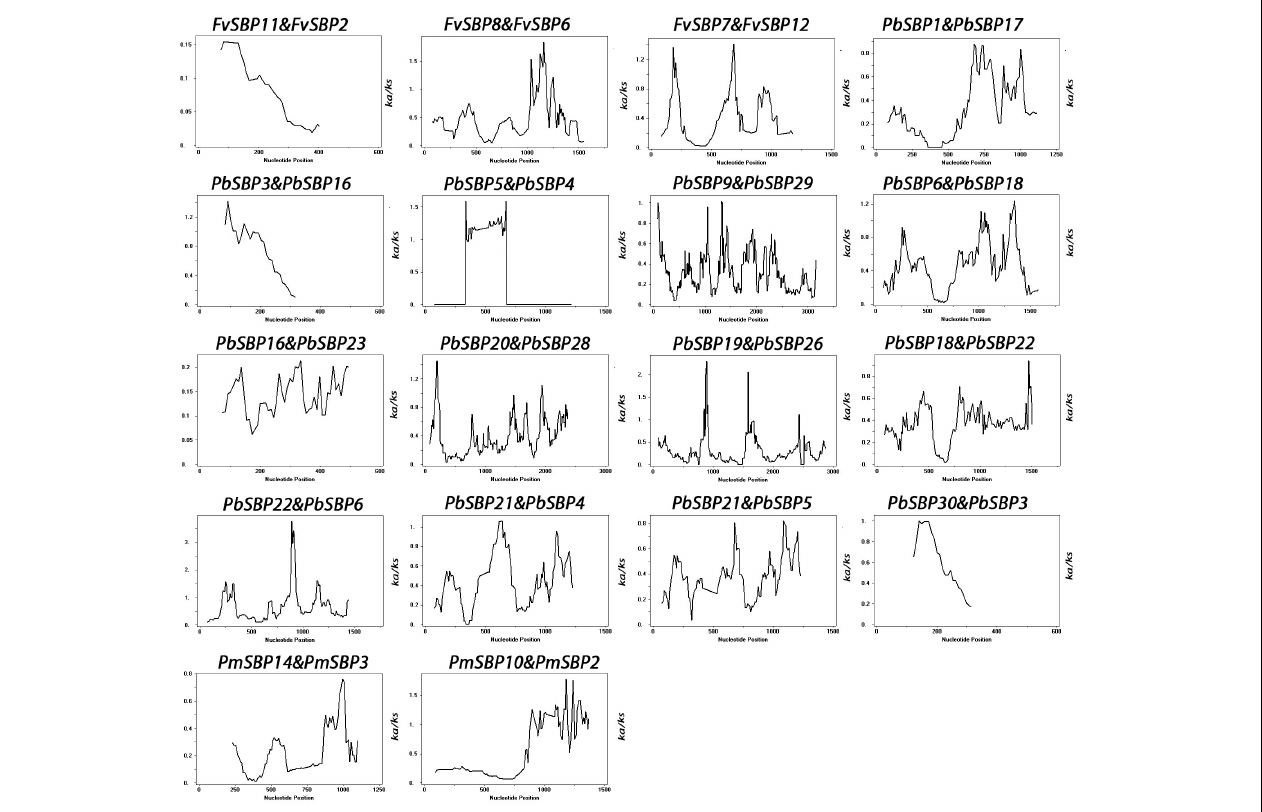
FIGURE 5 | Sliding window plots of duplicated SBP-box genes in Rosaceae species. The window size is 150 bp, and the step size is 9 bp. The X -axis indicated the synonymous distance within each